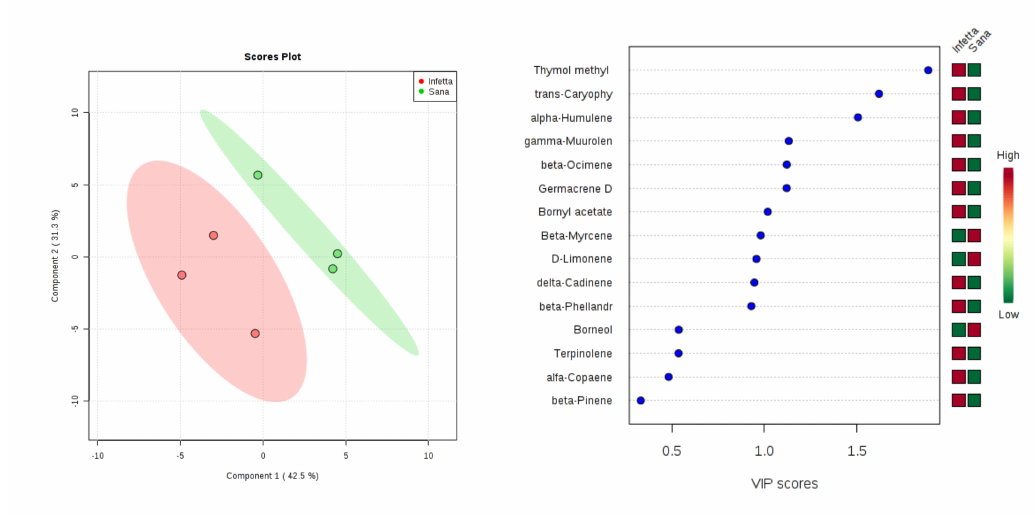
Figure 8. Partial least squares discriminant analysis applied to the Sampling #5 (PROCE-2) in Bova. Parameters and symbols as in Figure 4.